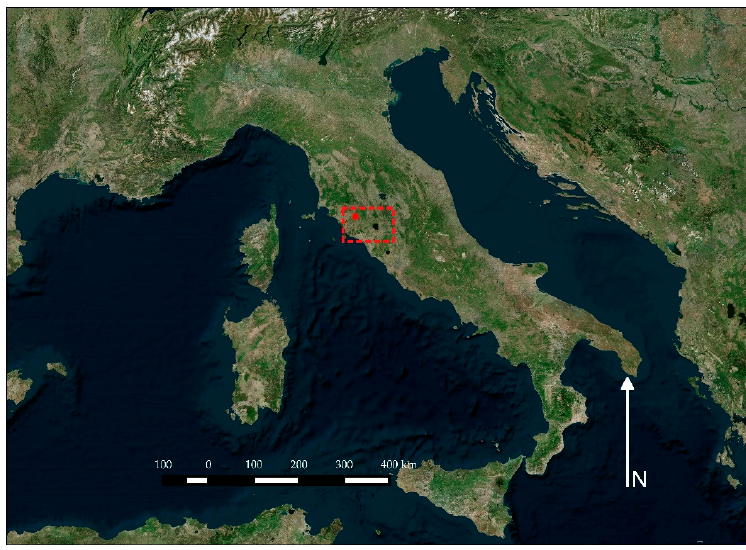
Figure 7. Study area.